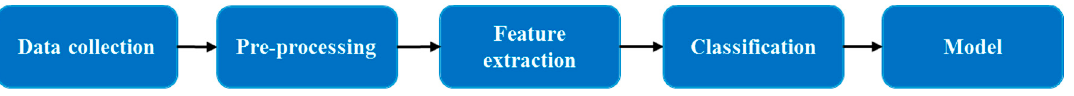
Figure 2. The flow chart of activity recognition.